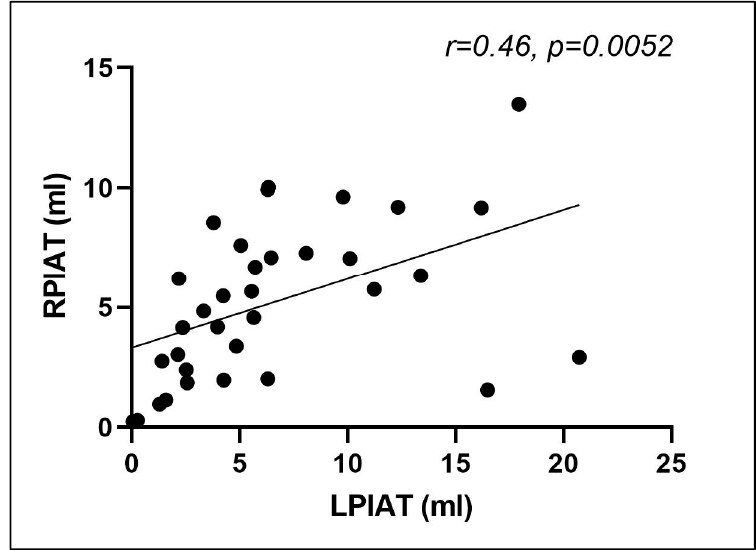
Figure 6. Correlation between right and left periiliac adipose tissue volumes ( r = 0.46, p = 0.0052).